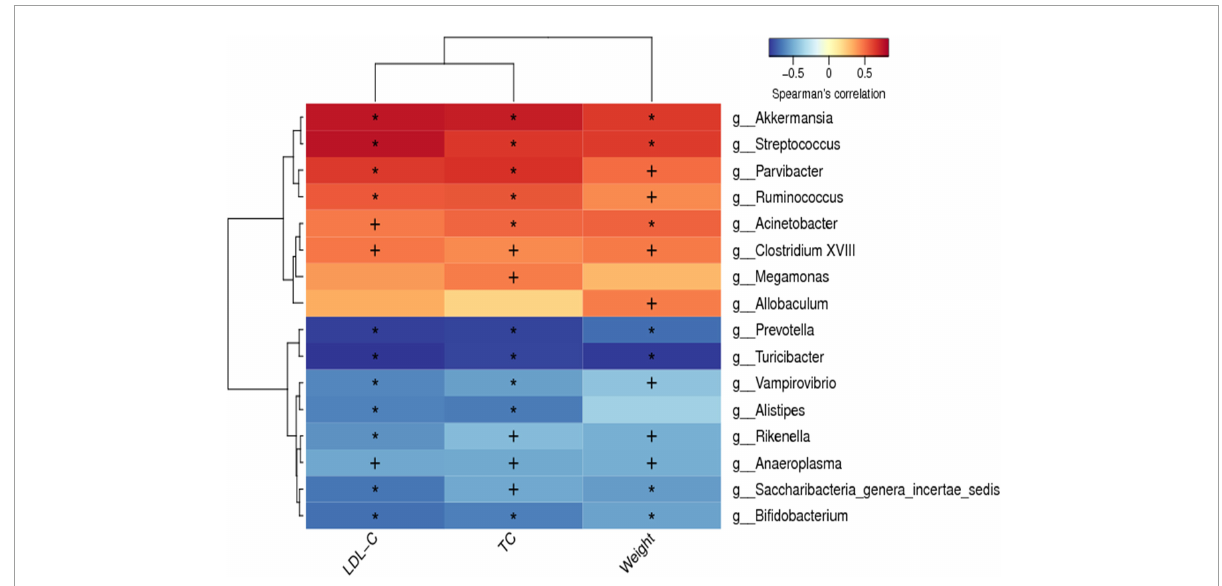
FIGURE8 Spearman correlations between hypercholesterolemia symptoms and gut microbiota. Positive correlations indicated by red cubes and negative correlations indicated by blue cubes. At the same time, the correlation significant test was carried out, when p < 0.05, + was used to mark the significance, when p < 0.01, * was used to mark the